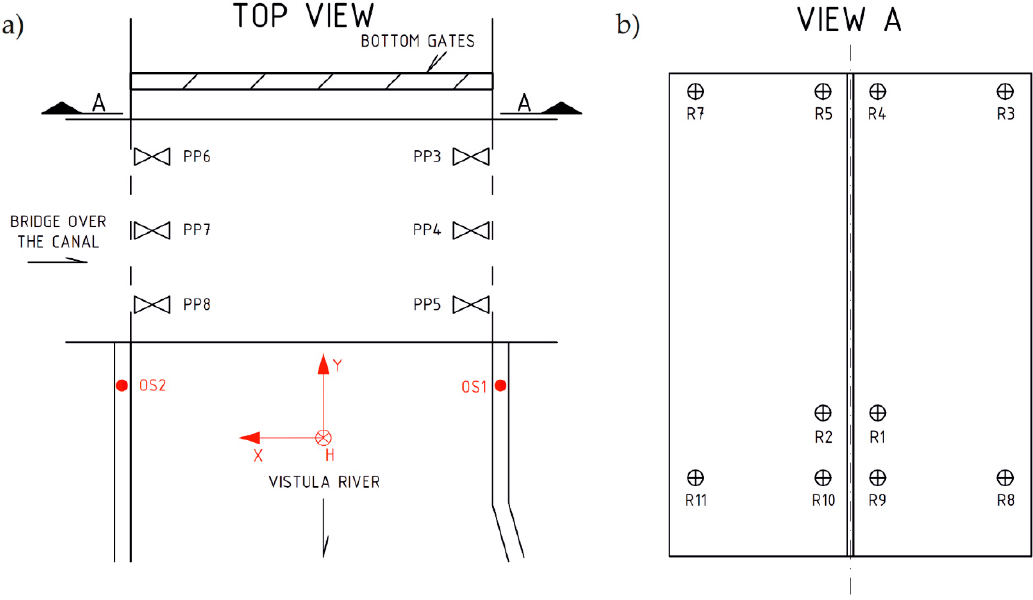
Figure 6. Sketch regarding a location of gates displacement measuring points. ( a ) Sketch regarding the location of control points and measurement positions, top view; ( b ) View from bottom water.